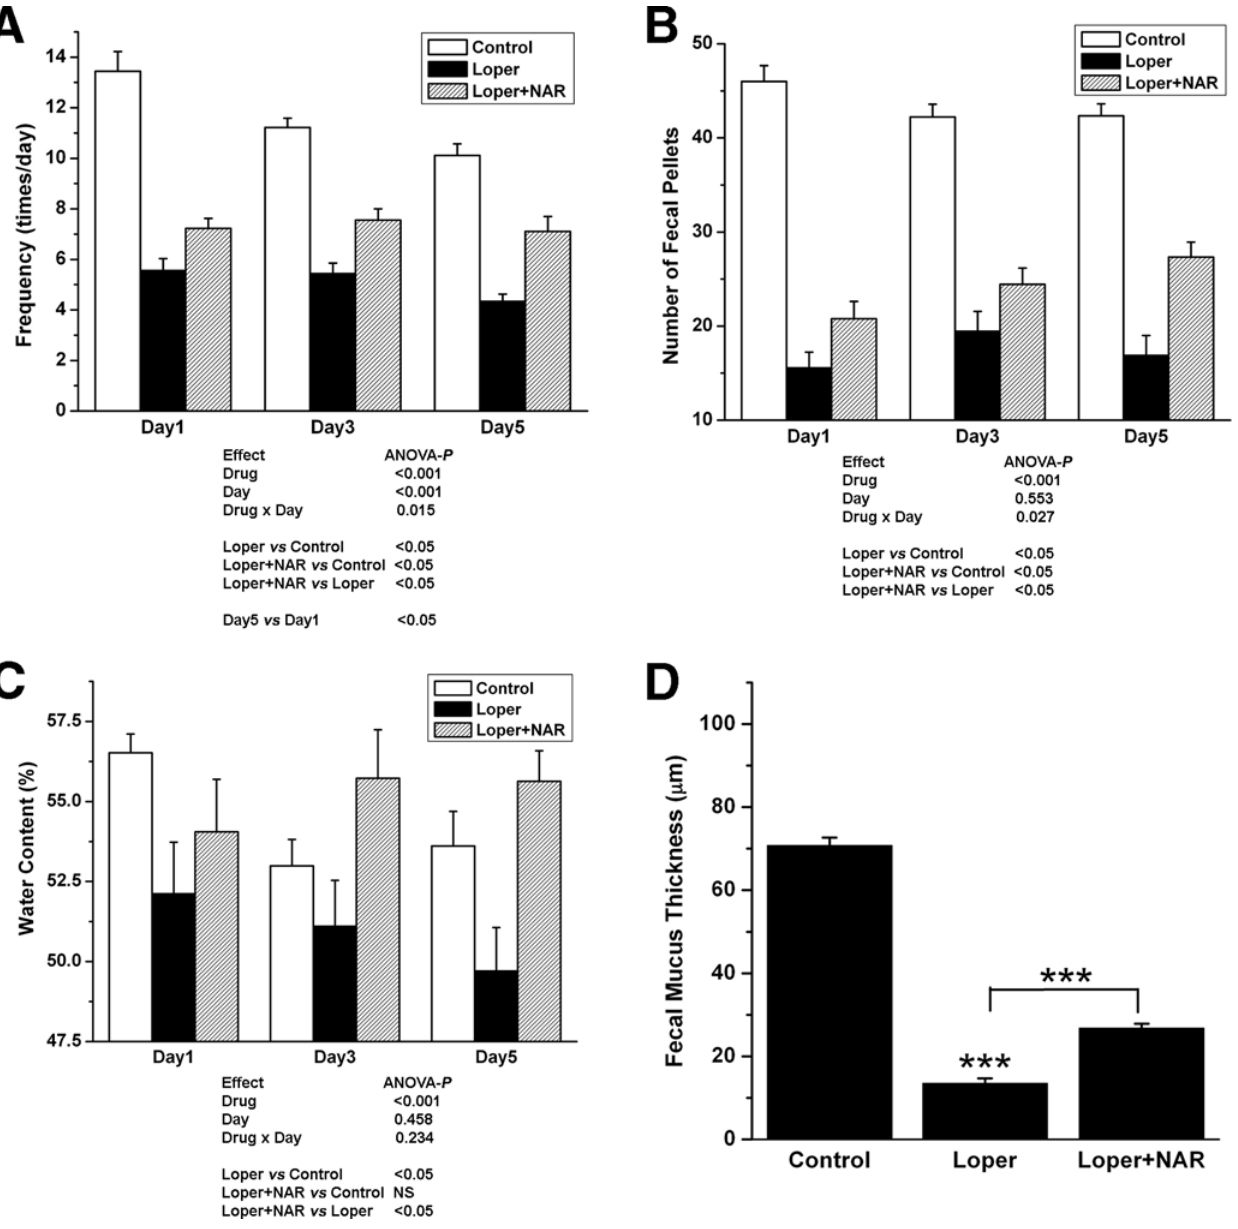
Figure 8. Effect of NAR on the loperamide-induced rat constipation model. (A) Frequency of feces excretion, (B) number, (C) water content (D) Thickness of fecal mucus of control (left bar in each column), loperamide-administered (middle bar in each column, 1.5 mg/kg, twice a day loperamide), and NAR-treated (150 mg/kg, twice a day) loperamide-administered rats (right bar in each column,) on experiment day. Each column represents the mean SE [***P ,